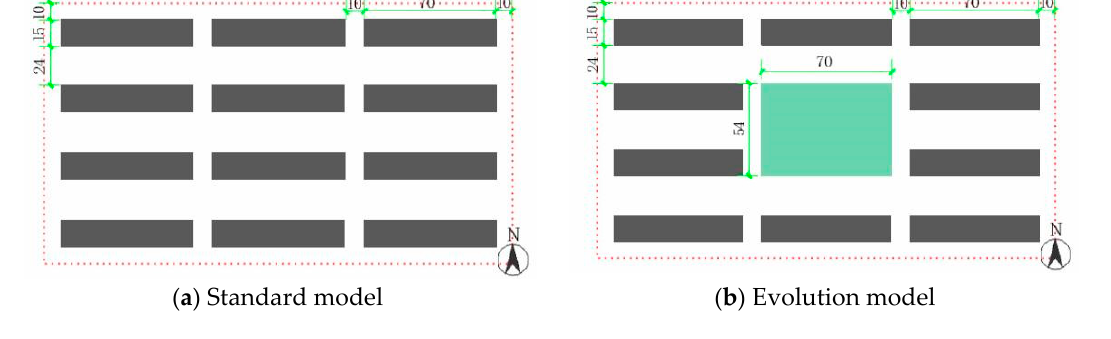
Figure 6. Standard model plan of residential area.